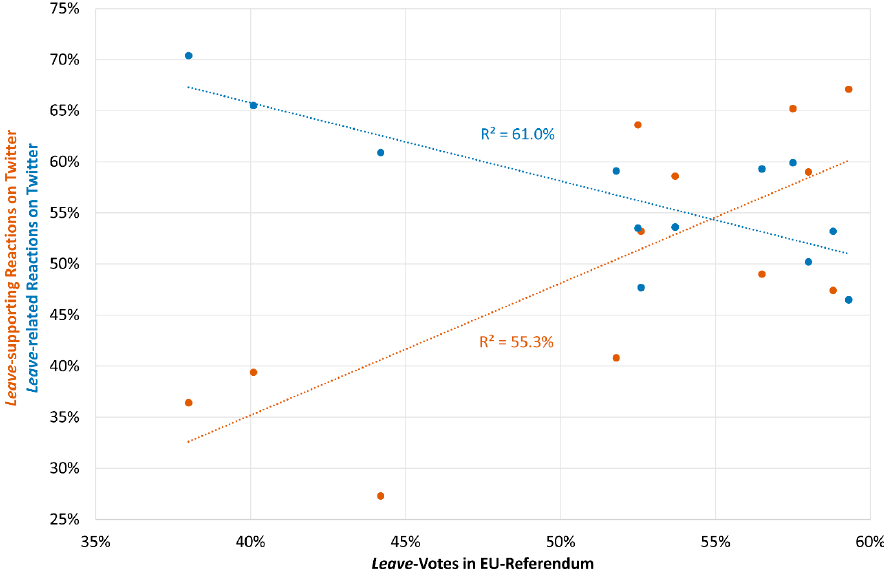
Figure 6. XY plot of leave votes in the EU referendum and prior leave -supporting reactions on